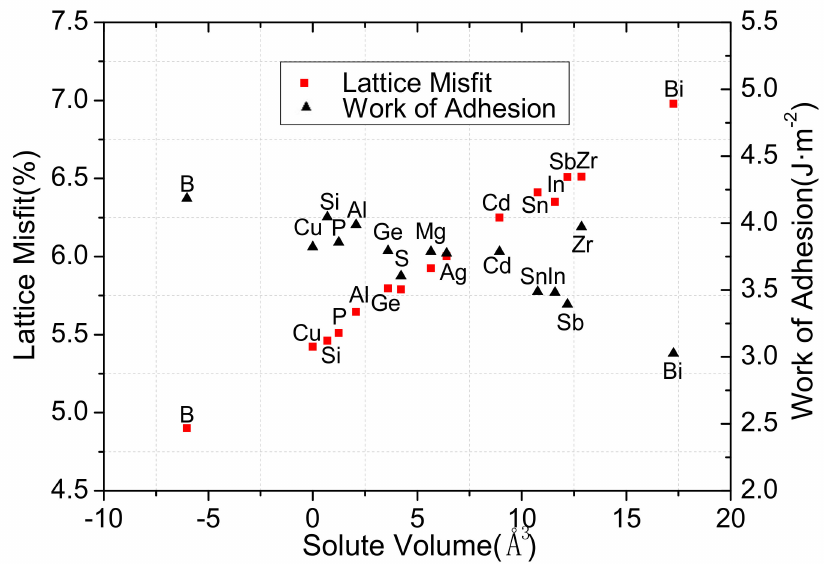
Figure 2. Work of adhesion and lattice misfit of Cu / γ –Fe interface as a function of solute